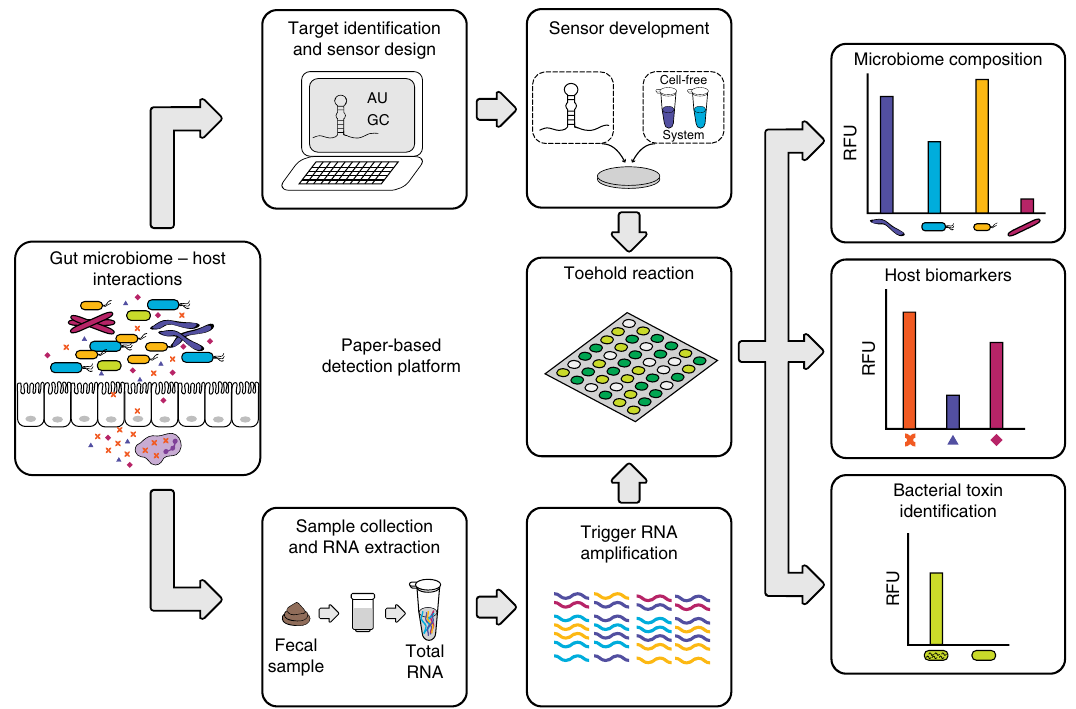
Fig. 1 Work fl ow for analysis of microbiome samples using our paper-based detection platform. Once key bacteria or mRNA targets have been identi fi ed, RNA toehold switch sensors and primers for isothermal RNA ampli fi cation are designed in silico. Sensors and primers are then rapidly assembled and validated in paper-based reactions. For subsequent use, total RNA is extracted from human fecal samples using a commercially available kit. Speci fi c RNAs are ampli fi ed via NASBA (nucleic acid sequence based ampli fi cation) and quanti fi ed using arrays of toehold switch sensors in paper-based reactions. Microbial and host biomarker RNA concentrations of the samples are determined using a simple calibration